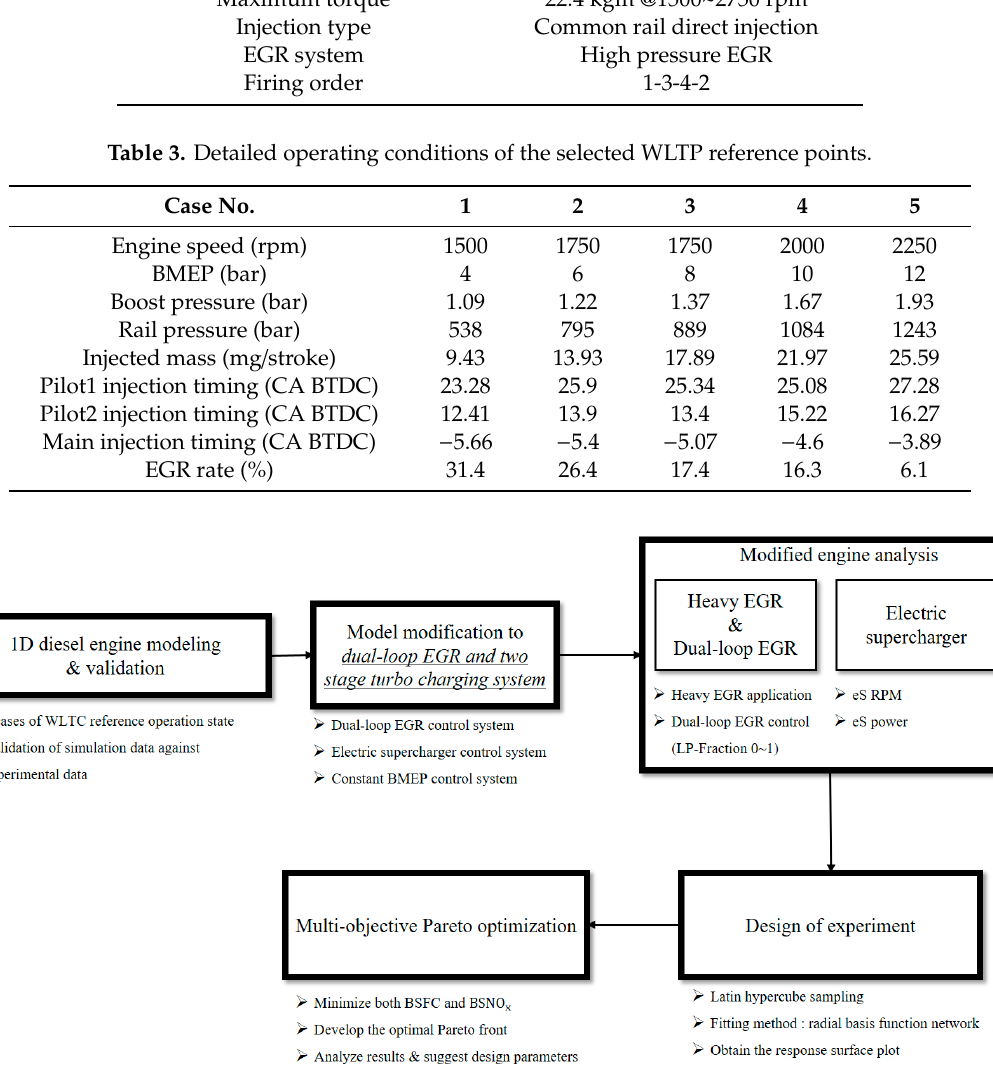
Figure 2. Overview of the research plan.